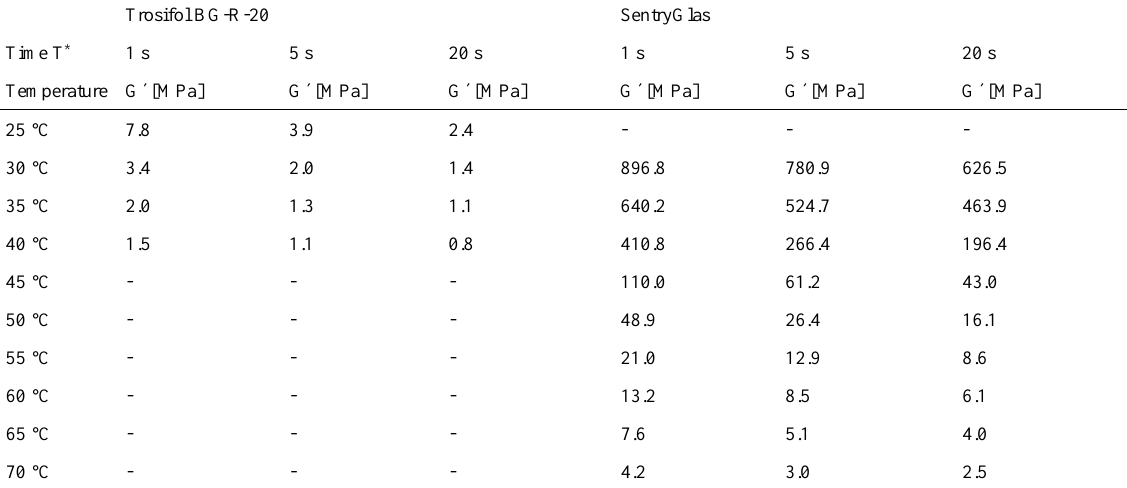
Table 2: Representative Trosifol and SentryGlas Shear Storage Modules experimental